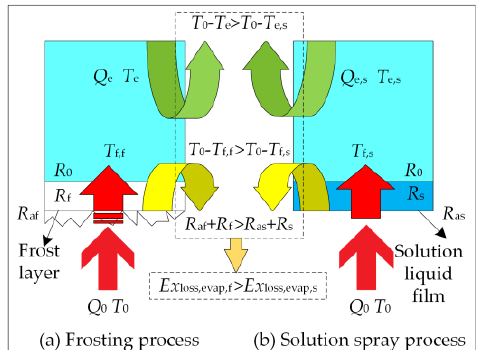
Figure 29. Exergy loss analysis of the evaporator in frosting process and solution spray process. Where, R as is thermal resistance between air and liquid film, (m 2 · K)/kW; R s is thermal resistance of solution liquid film on the evaporator surface, (m 2 · K)/kW; T f,f and T f,s is temperature of the evaporator surface in frosting process and solution spray process, respectively, ◦ C; Ex loss,evap,f and Ex loss,evap,s are exergy loss rate of the evaporator in frosting process and solution spray process, respectively, kW.